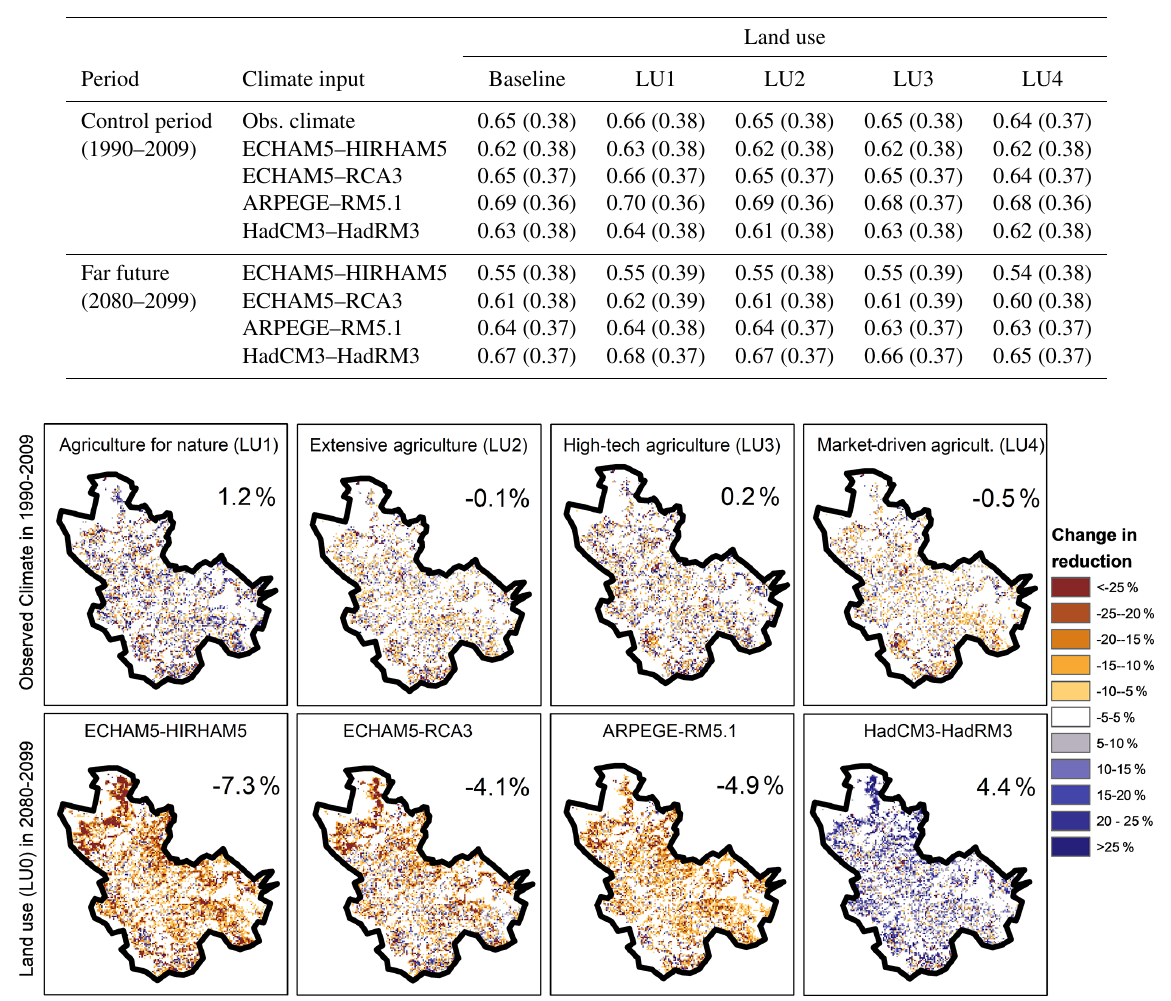
Figure 3. Difference in nitrate reduction potential maps between (top row) four land use scenarios LU1–4 (scenarios 2–5) and the baseline scenario with LU0 (scenario 1). The bottom row shows the four future climate model scenarios (scenarios 26, 31, 36, and 41) and the reduction maps for the corresponding climate model reference period (scenarios 6, 11, 16, and 21), all for